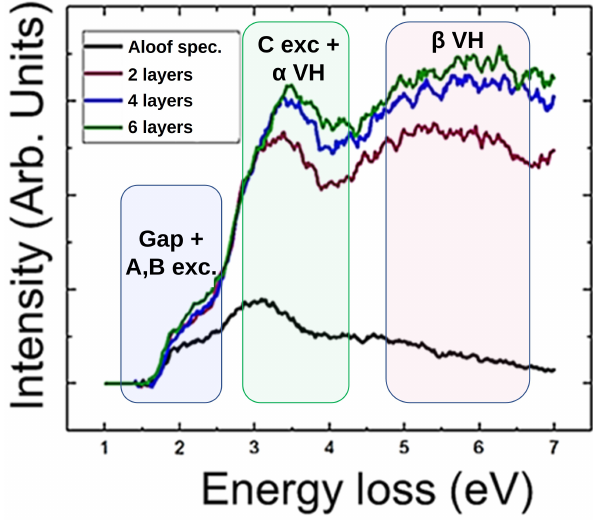
Figure 3. Integrated spectra from the regions highlighted in Figure 2 of a Mo 0.5 W 0.5 S 2 flake. Same colours are assigned to the integrating window and integrated spectra for clarity. Three different regions of interest are highlighted: The one corresponding to the study of the band gap and the presence of the A and B excitonic features (blue), the one corresponding to the C excitonic feature, overlapped as well with the α van Hove feature (green) and the one corresponding to the β van Hove feature.